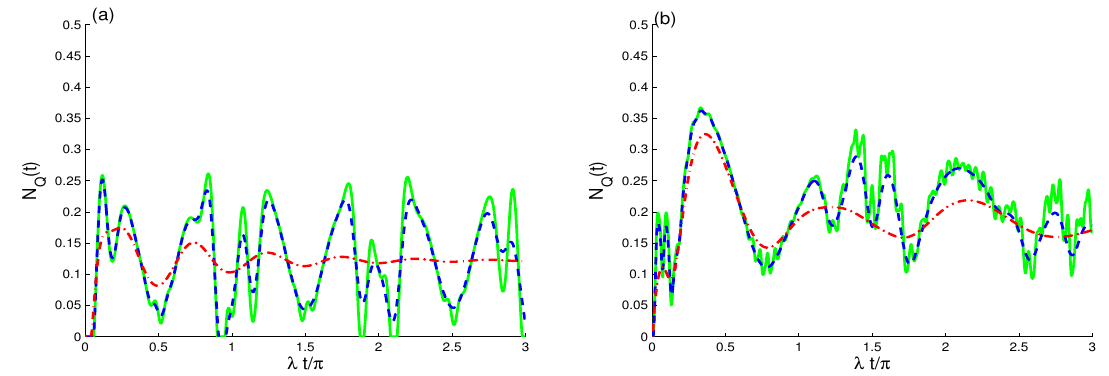
Figure 8. The N Q ( t ) for k = 1 and α = 5 with different decoherence values of γ : γ / λ = 0 (green solid 4 curves), γ / λ = 0.001 (blue dashed curves), and γ / λ = 0.03 (red dashed dot curves). With J / λ = 0 in ( a ) and J / λ = 30 in ( b